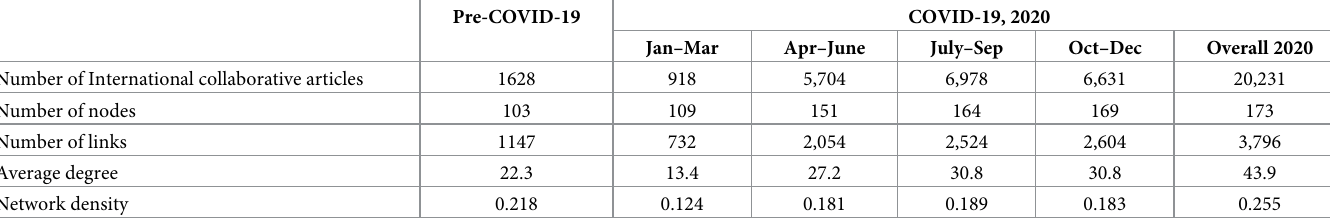
Table 7. Network metrics in coronavirus